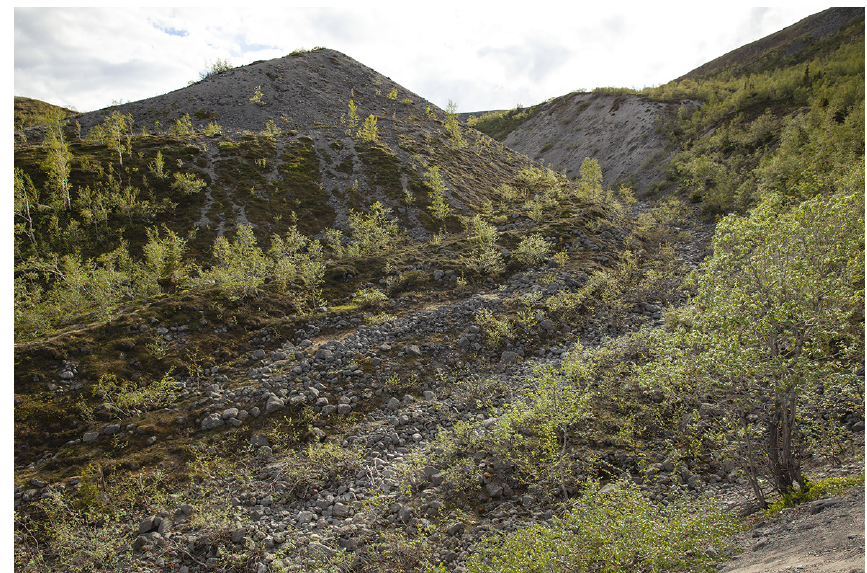
Figure 2. Several generations of debris flow fans distinguished by relative elevation and vegetation succession stages below the V-shaped cut into moraine under the southern slope of the Vudjavrchorr Mountain.